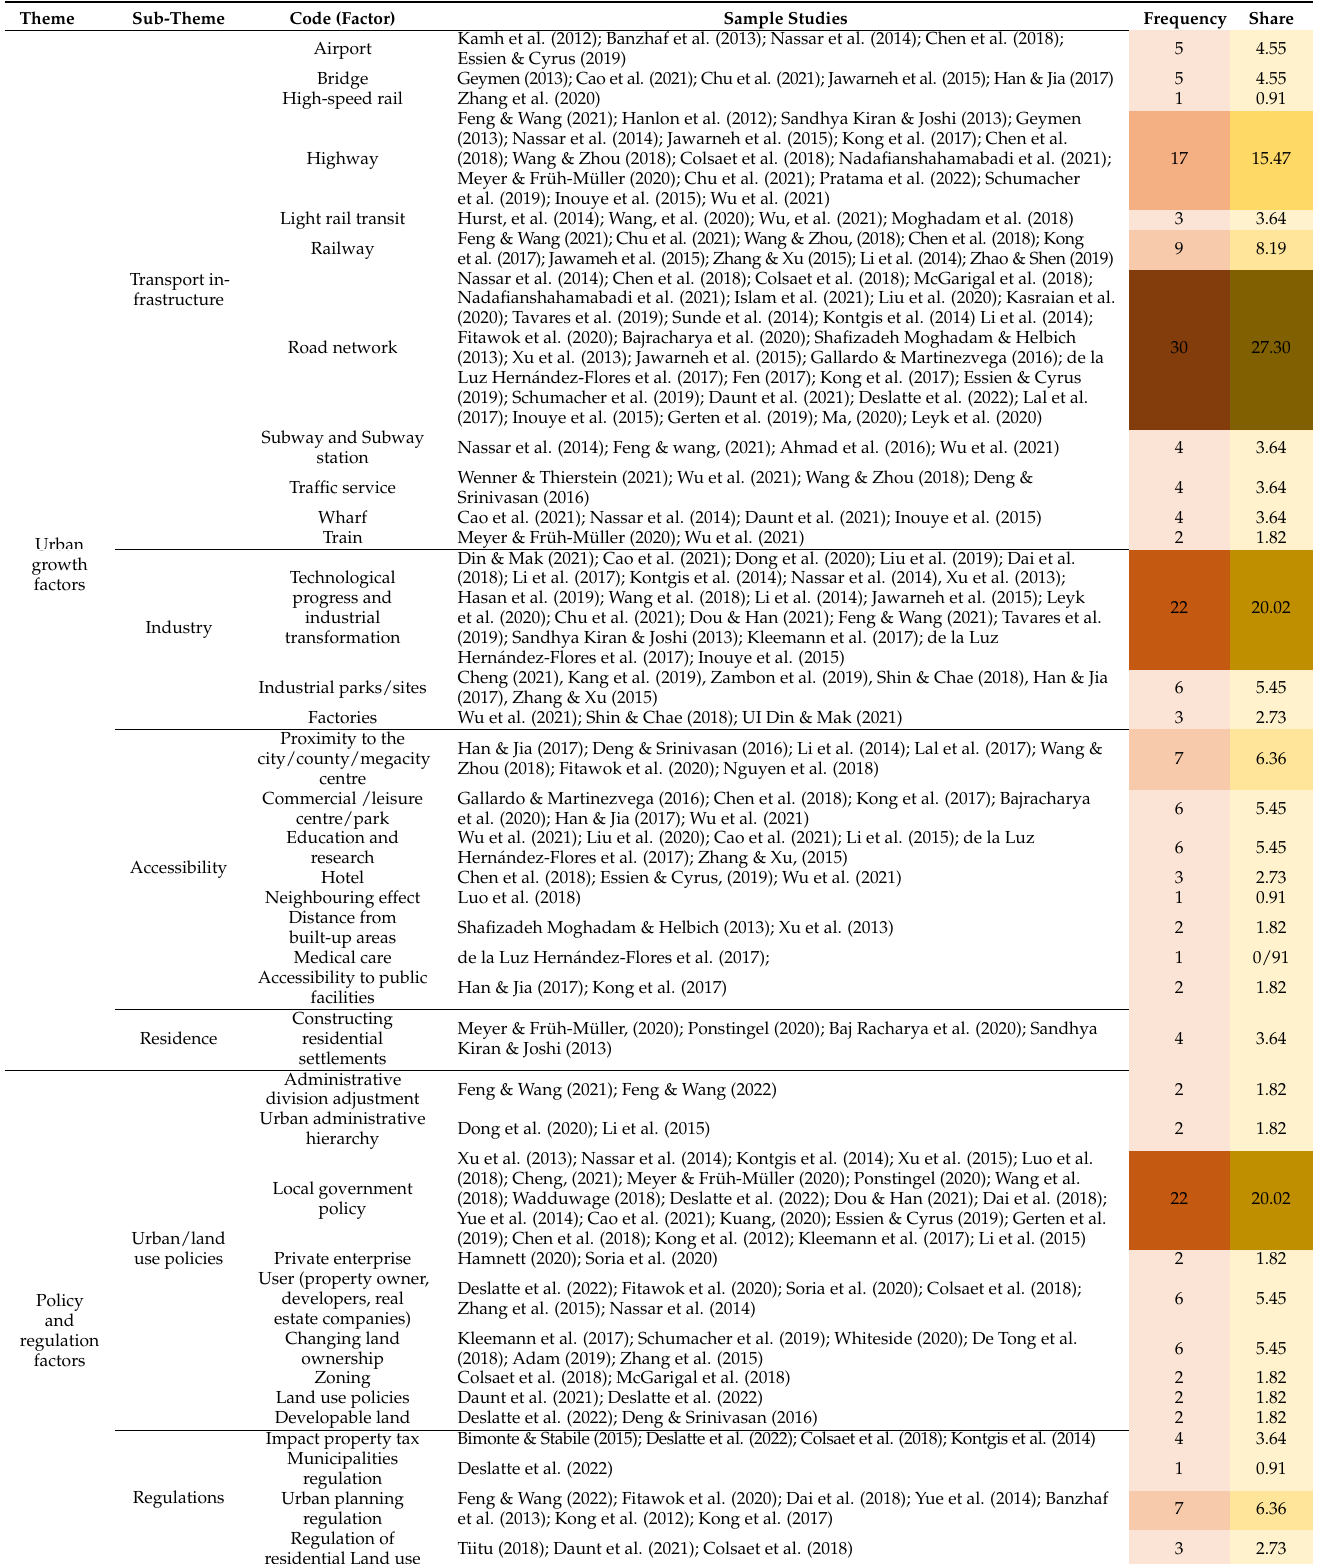
Table 4. Factors driving land use and land cover change